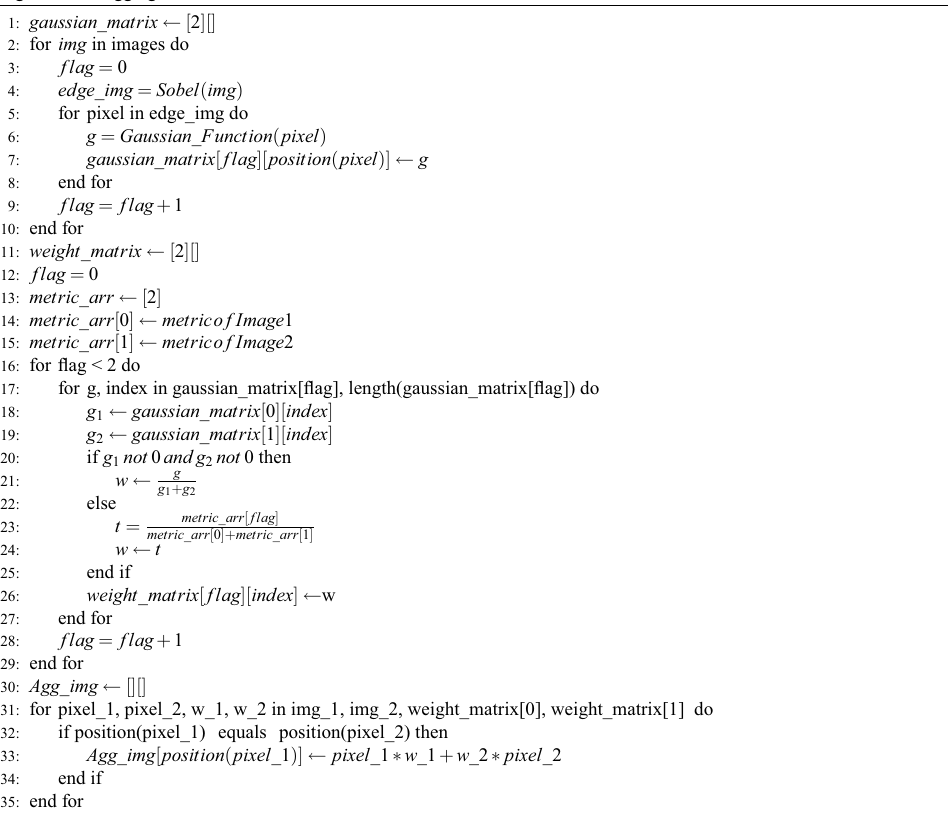
Algorithm 1 Aggregation Method